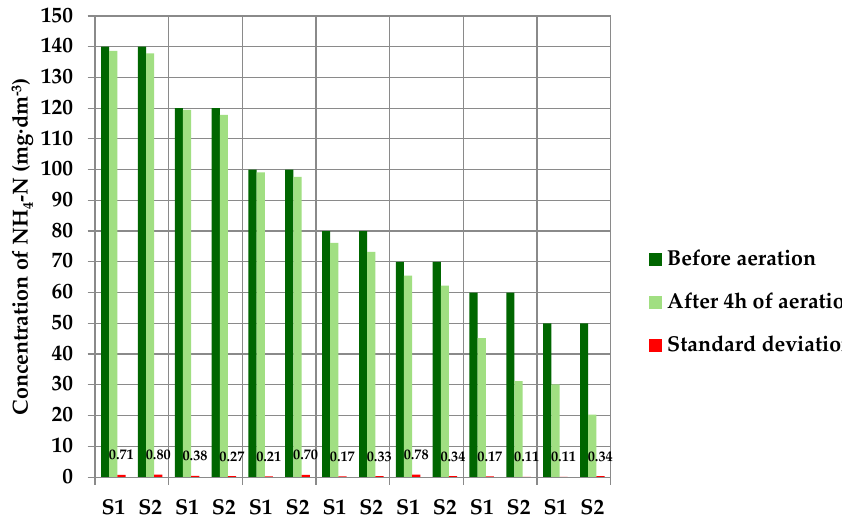
Figure 2. Influence of nitrifying bacteria cultures on the efficiency of NH 4 -N oxidation—static conditions. Statistical analysis showed significant differences in concentration of NH 4 -N between the samples containing cultures of nitrifying bacteria (with a biomass of 0.25 mg), and the control samples, only when the concentration of ammonium nitrogen was not exceeded 60.00 mg · dm − 3 (for 50 and 60 mg · dm − 3 of NH 4 -N). When the concentration of ammonium nitrogen was exceeded 60.00 mg · dm − 3 (70–140 mg · dm − 3 ), there were no significant differences in concentration of NH 4 -N between the samples containing cultures of nitrifying bacteria, and the control samples. The analysis showed significant differences in average concentration of NH 4 -N in control samples and samples with cultures of nitrifying bacteria after 4 h of aeration, only when the concentration of ammonium nitrogen was not exceeded 60.00 mg · dm − 3